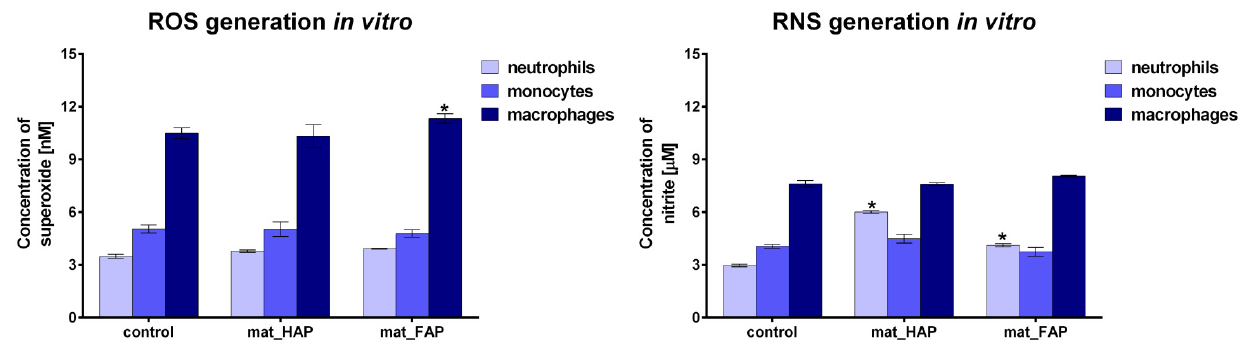
Figure 7. Evaluation of ROS/RNS generation by human immune cells (control—cells cultured without biomaterials; * statistically significant results compared to corresponding control cells, p < 0.05, unpaired t -test).